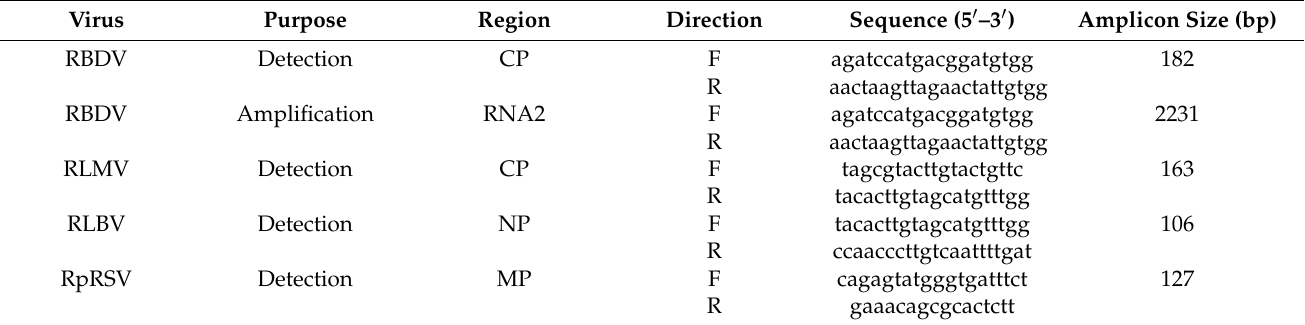
Table 1. Sequence information of primer pairs used in RT-PCR and PCR assays for detection and amplification of RBDV, RLMV, RLBV, and RpRSV [25]. NP = nucleocapsid